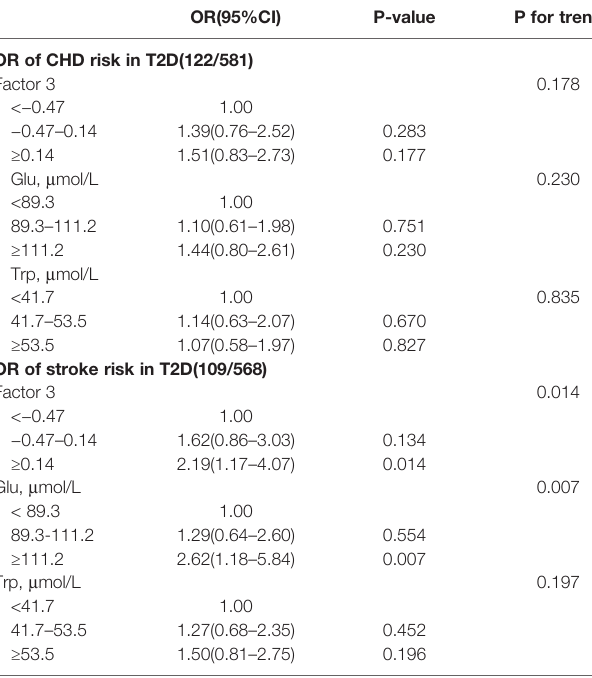
TABLE 6 | Odds ratio of factor 3 and individual amino acids for CHD or stroke risk in T2D. OR(95%CI) P-value P for trend OR of CHD risk in T2D(122/581) Factor 3